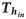
Time constant for mass production in response to a stepped variation in Thin.